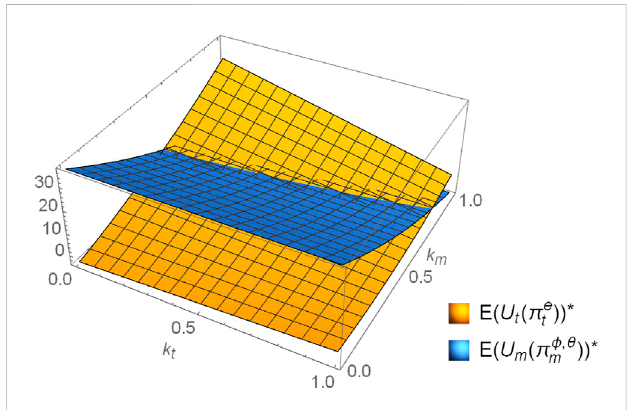
FIGURE 4 The impact of k t and k m onthe expected utility ofthemanufacturer and the ESCO.